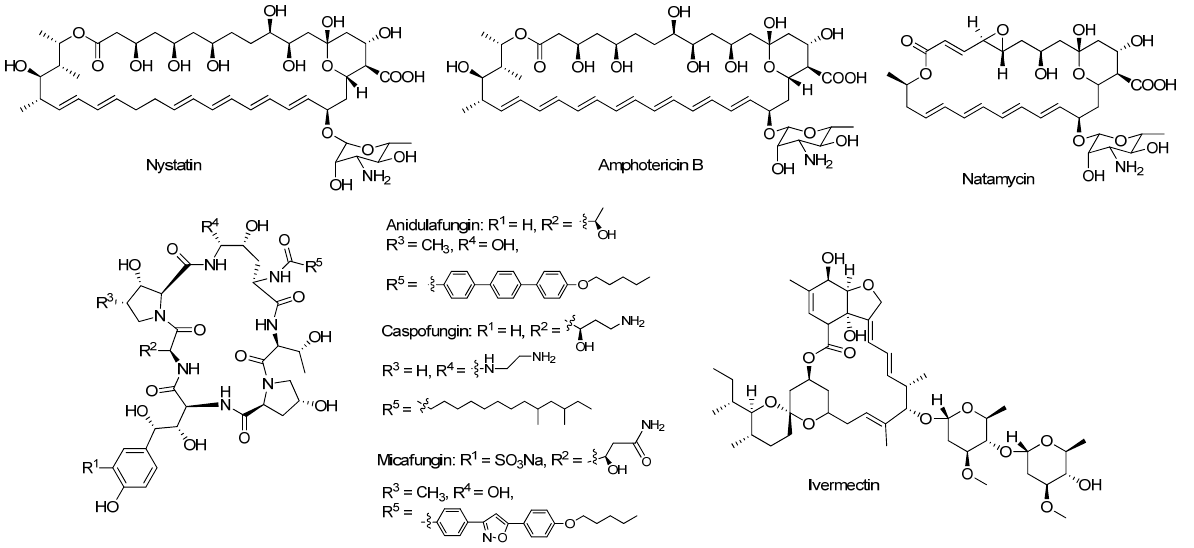
Figure 3. Clinically used macrocyclic antifungal and antiparasitic